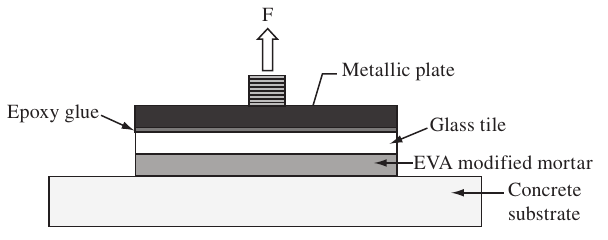
Figure 2. Test method for adhesion in tension for bond strength measure-